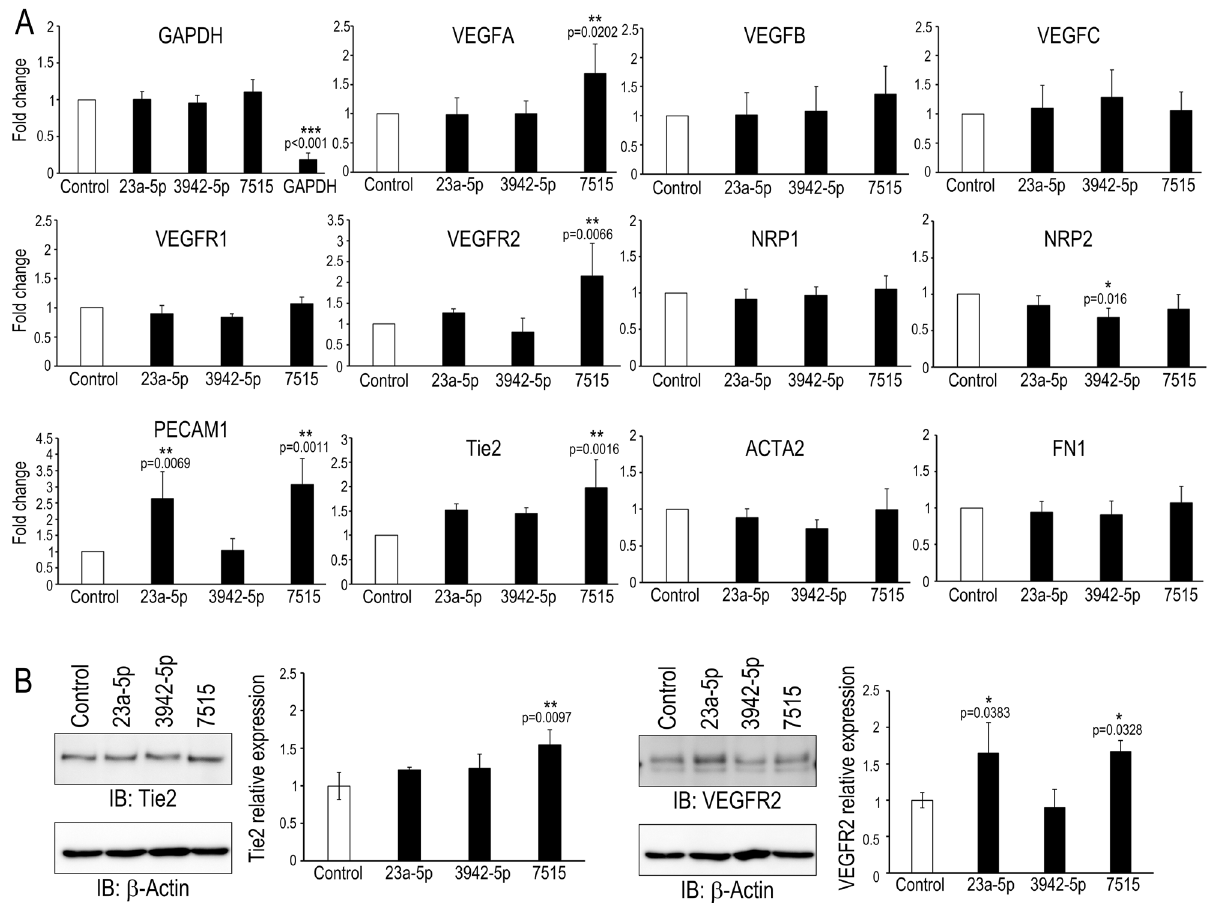
Figure 5. Effects of miRNA mimics on monkey SCE cells. ( A ) Quantitative RT-PCR was performed using the indicated primers to analyze monkey SCE cells transfected with miRNA mimics (miR-23a-5p mimic (23a- 5p), miR-3942-5p mimic (3942-5p), miR-7515 mimic (7515)) or a miRNA positive control targeting GAPDH (control). Fold changes in the indicated mRNA expression relative to the level of the miRNA mimic control are presented (n = 4 for each group). *: p < 0.05, **: p < 0.01, ***: p < 0.001 by Dunnett’s test. VEGF: vascular endothelial growth factor, VEGFR: VEGF receptor, NRP: neuropilin, PECAM: platelet endothelial cell adhesion molecule, ACTA: α-smooth muscle actin, FN: fibronectin. ( B ) Western blot analysis of cell lysates after transfection with the indicated miRNA mimic. The graphs show the relative intensity (determined with Image J software) of the indicated proteins compared to β-actin, which was used as a loading control (n = 3). *: p < 0.05, **: p < 0.01 by Dunnett’s test.